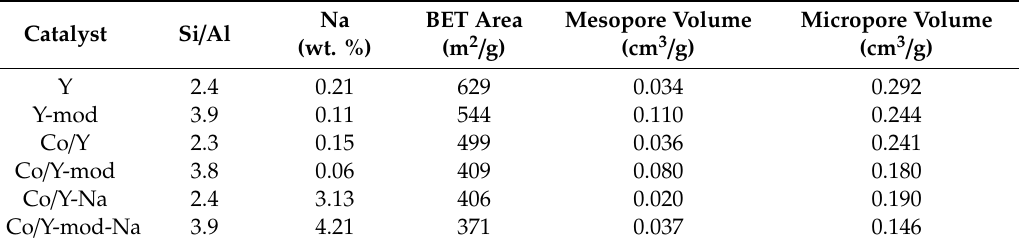
Table 1. Textural properties of the catalysts and supports studied in this work.